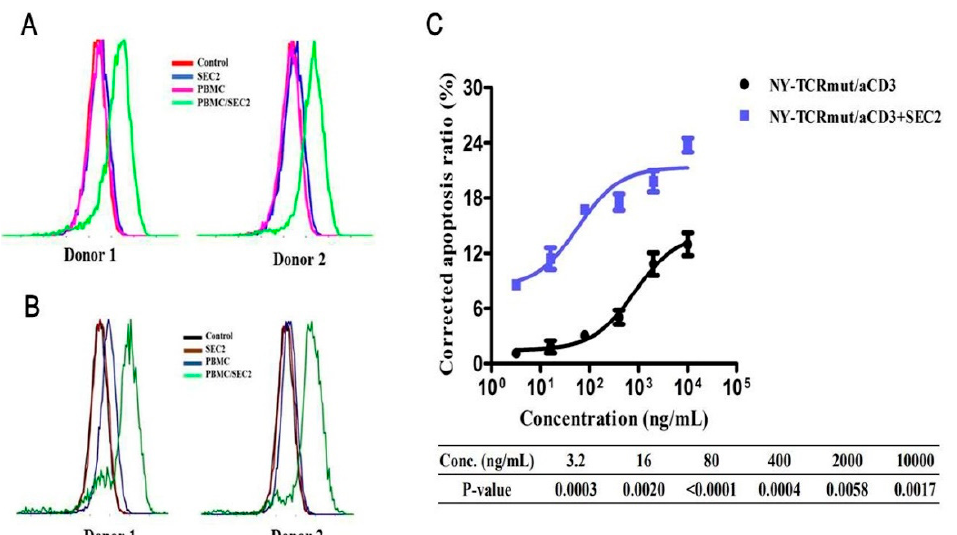
Figure 5. SEC2 enhanced the anti-tumor activity of NY-TCRmut/aCD3. ( A ) The HLA-A*02 expression level in A375 cells was up-regulated after being stimulated by the secretory substances of SEC2-activated T cells. The HLA-A*02 expression level was determined using flow cytometry, and the shift of the peaks to the right indicated the higher expression level of HLA-A*02. The PBMC were from two donors. ( B ) The NY/A02 expression level on the A375-NY cell surface was up-regulated after being stimulated by the secretory substances of SEC2-activated T cells. The NY/A02 expression level was determined using flow cytometry, and the shift of the peaks to the right indicated the higher expression level of NY/A02. The PBMC were from two donors. ( C ) Lysis of A375-eGFP cells over 48 h caused by PBMC in the presence of titrated concentrations of NY-TCRmut/aCD3 with or without 2 ng/mL SEC2 (n = 3). Lysis was determined using cell apoptosis. NY-TCRmut/aCD3 was able to redirect the lytic activity of T cells more effectively at different concentrations with 2 ng/mL SEC2.